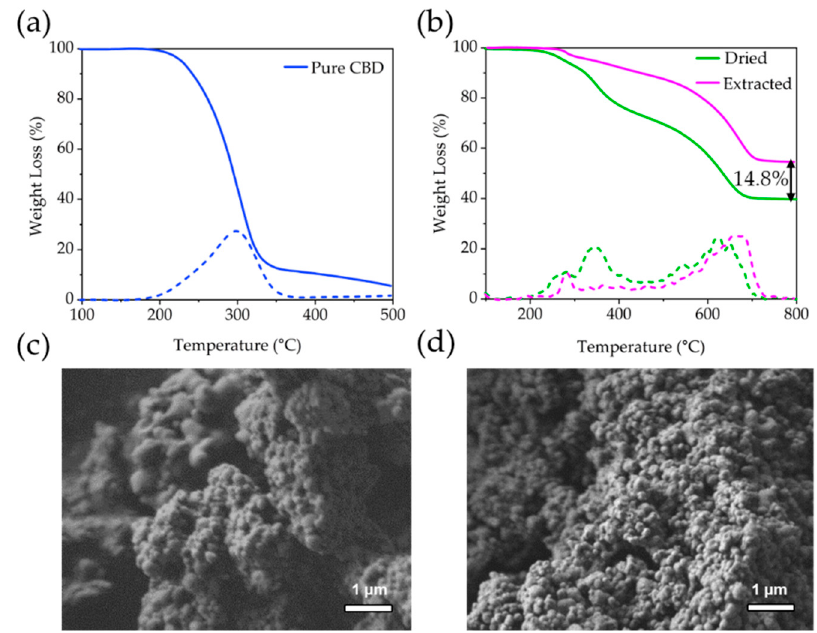
Figure 1. Thermogravimetric analysis profiles of ( a ) pure cannabidiol (CBD) and ( b ) CBD encapsu- lated within organosilane particles (CBD-Silica), after drying (Dried) and after extraction (Extracted) of the loaded CBD. Dotted lines correspond to the first derivative of the weight-loss curves shown.